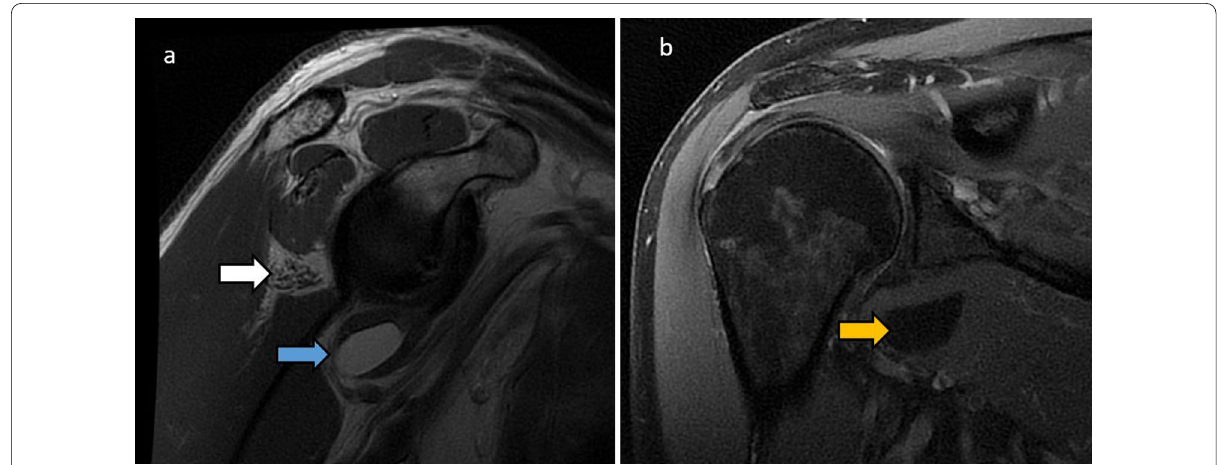
Fig. 3 70-year-old with underwent MRI for rotator cuff tendinopathy. Sagittal proton density (PD) shoulder ( a ) shows severe fatty atrophy of the teres minor (white arrow). There is a lipomatous tumour with complete fat-suppression on the coronal PDFS sequence ( b , yellow arrow), which is within the subscapularis muscle belly inferiorly and is impinging on the quadrilateral space and the traversing axillary nerve ( a , blue arrow). This